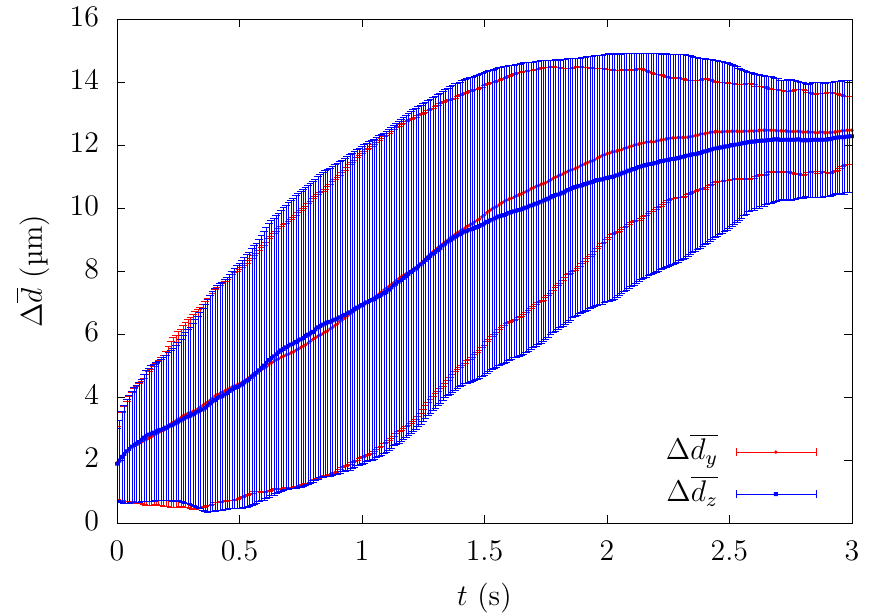
Figure 2. Comparison of the time history of the ensemble-averaged distance ∆ d between the height and width direction for Ht = 20%, ˙ γ w = 972 s − 1